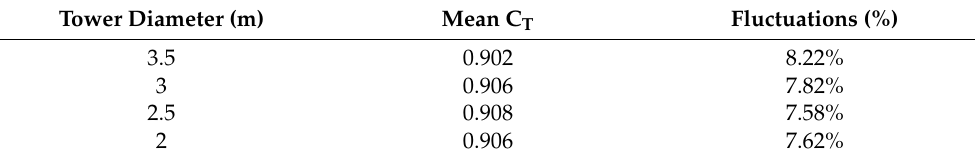
Table 2. Fluctuation in the coefficients of thrust for different tower diameters.